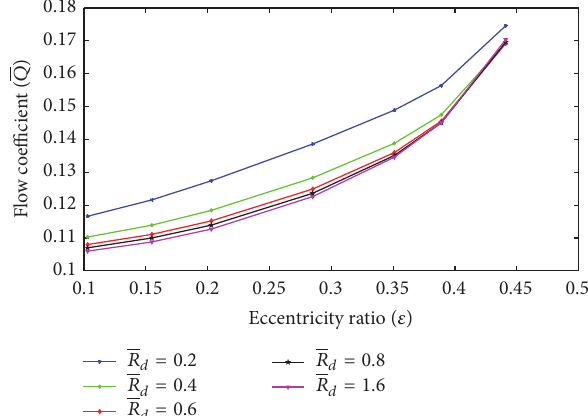
Figure 3: Effect of relief track depth ratio on load carrying capacity.